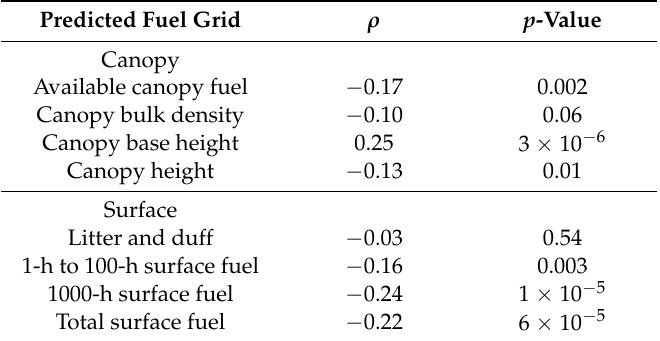
Table 6. Spearman’s correlation values, ρ , between percent mortality cover (independently estimated by gridded ADS data) and aggregated canopy and surface fuel grids for 1-km forested (>50% canopy cover) grid cells. n =